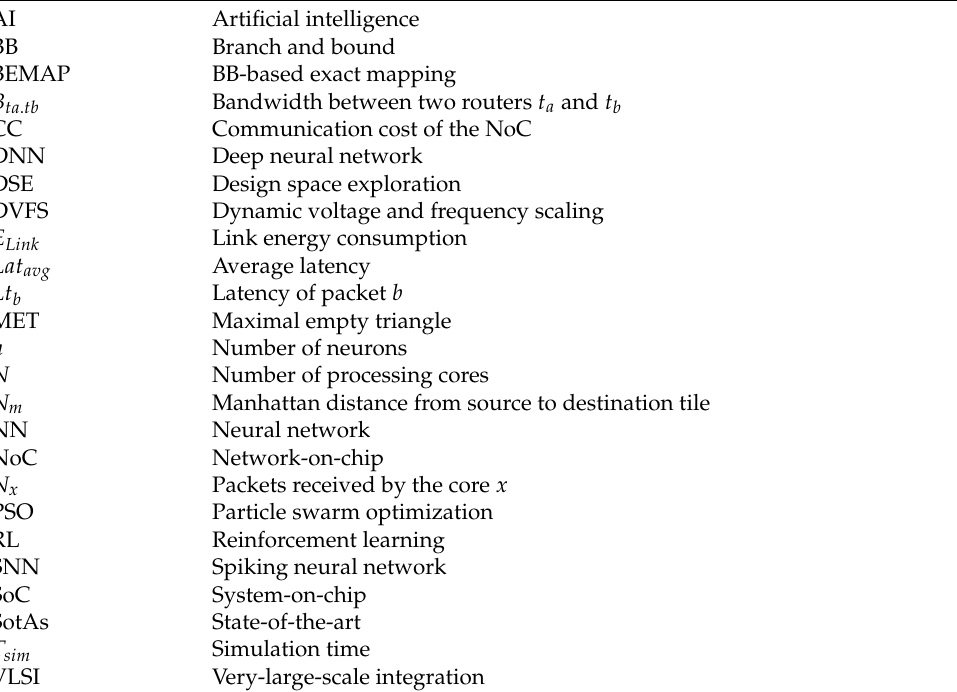
Table 1. List of